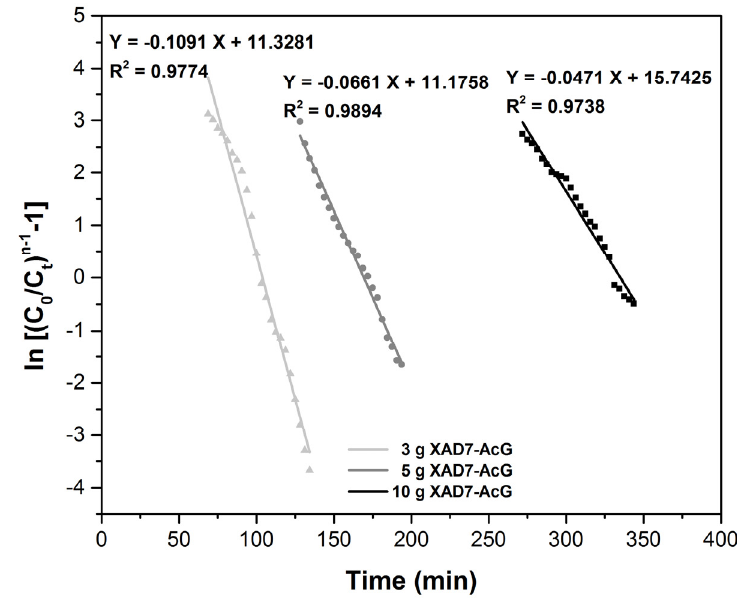
Figure 8. Clark plots for the adsorption of Au (III) in the fixed-bed column, at various amounts of adsorbent material. Table 1. Au (III) adsorption process parameters on fixed bed column. Column